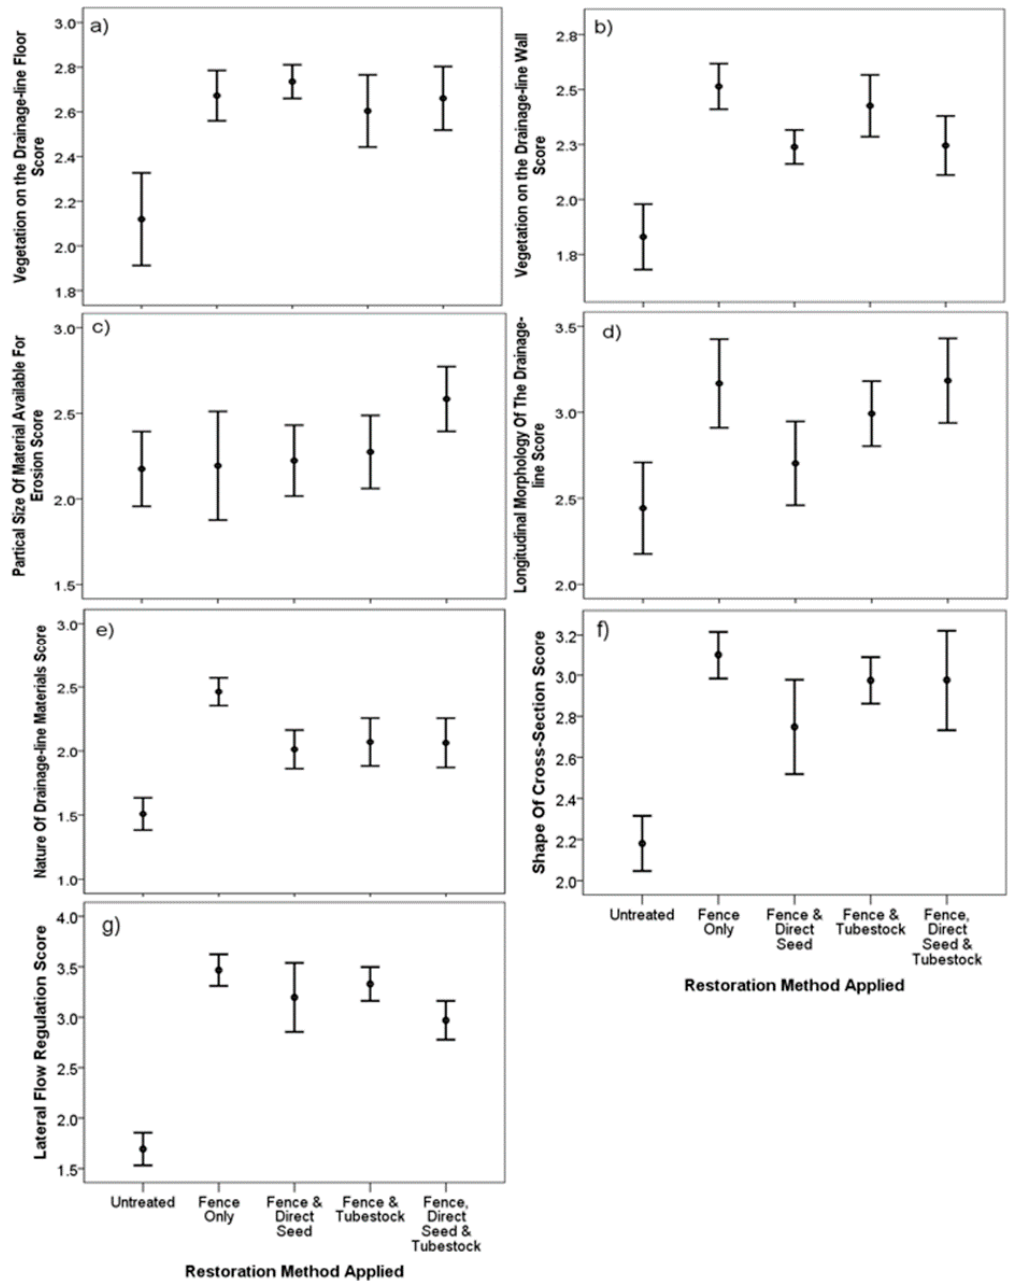
Figure 7. Mean scores for the seven indicators ( a – g ) within ESA 10 years after restoration for sites restored as part of the Bidgee Banks Restoration Project (BBRP) for each of four restoration methods. Untreated site scores are provided as a comparison. Error bars represent ± SE. The y-axis varies between